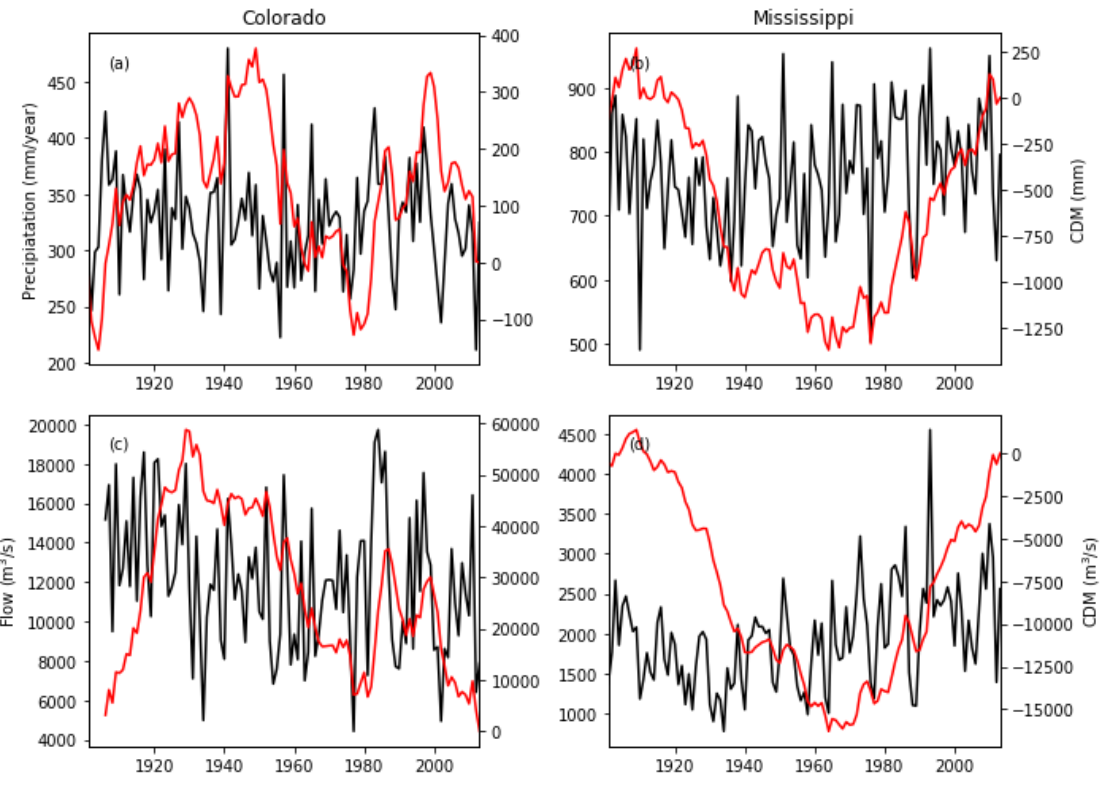
Figure 9. Time series and CDM plots for average annual precipitation and annual flows for the Colorado at Lees Ferry (1906–2013) ( a , c ) and the Mississippi at Keokuk (1901–2013) ( b , d ). Table 2. H estimates for catchment boundary box average annual precipitation (P) and annual flows (Q) for the Colorado river at Lees Ferry (1906–2013) and the Mississippi at Keokuk (1901–2013).